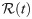
Left: The time series of fatalities for a number of countries. Right: the time derivative of the curve of fatalities is converted into R(t) according to Eq (19).